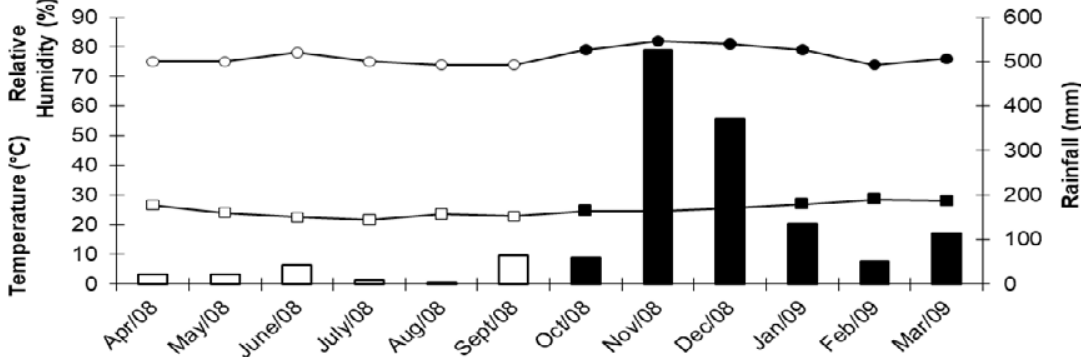
Fig 1 . Climatic conditions between April 2008 and March 2009 at the Itaoca Inselberg in the Atlantic Forest in southeastern Brazil. Dry season: white color; Wet season: black color. Temperature: square; Relative Humidity: circles; Rainfall: